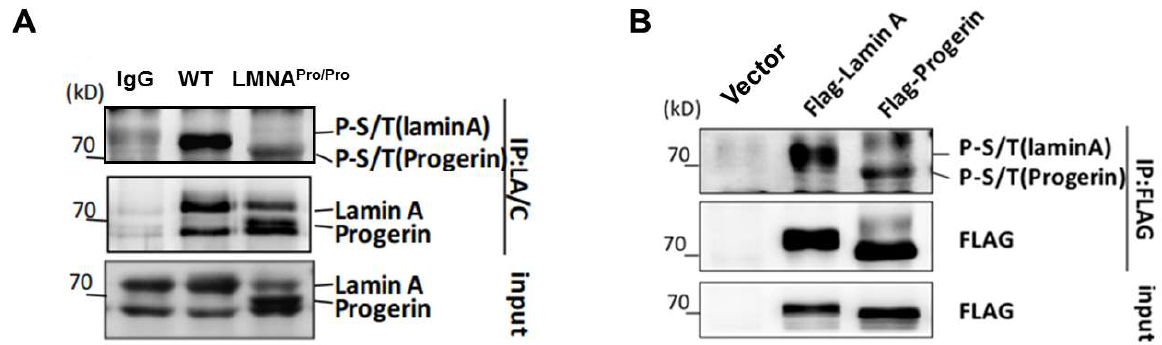
Figure 1. Decreased phosphorylation of progerin compared with lamin A. ( A ) Western blots showing the phosphorylation levels of wild type lamin A and LMNA pro/pro (progerin) in MEF cells, detected by a universal serine/threonine antibody. ( B ) FLAG-lamin A and FLAG-progerin were expressed in HEK293 cells and immunoprecipitated using an anti-FLAG antibody; The universal serine/threonine antibody was used to detect the phosphorylation levels of progerin and lamin A.